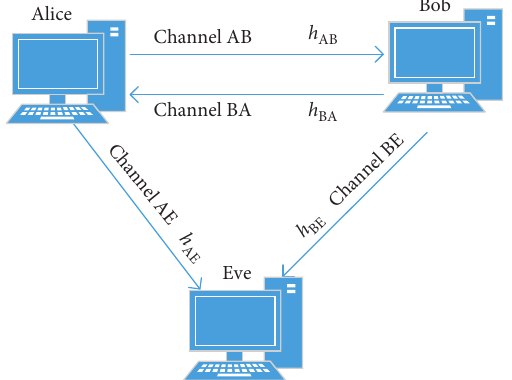
Figure 1: Wireless eavesdropping channel system